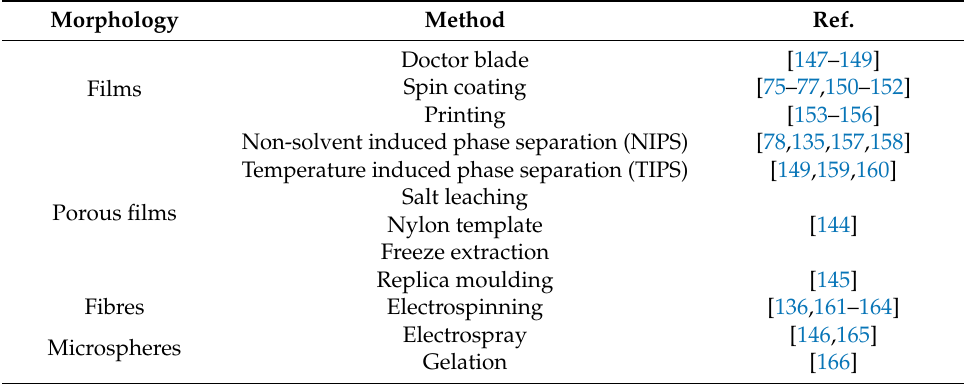
Table 3. Processing of PVDF and its copolymers for obtaining different